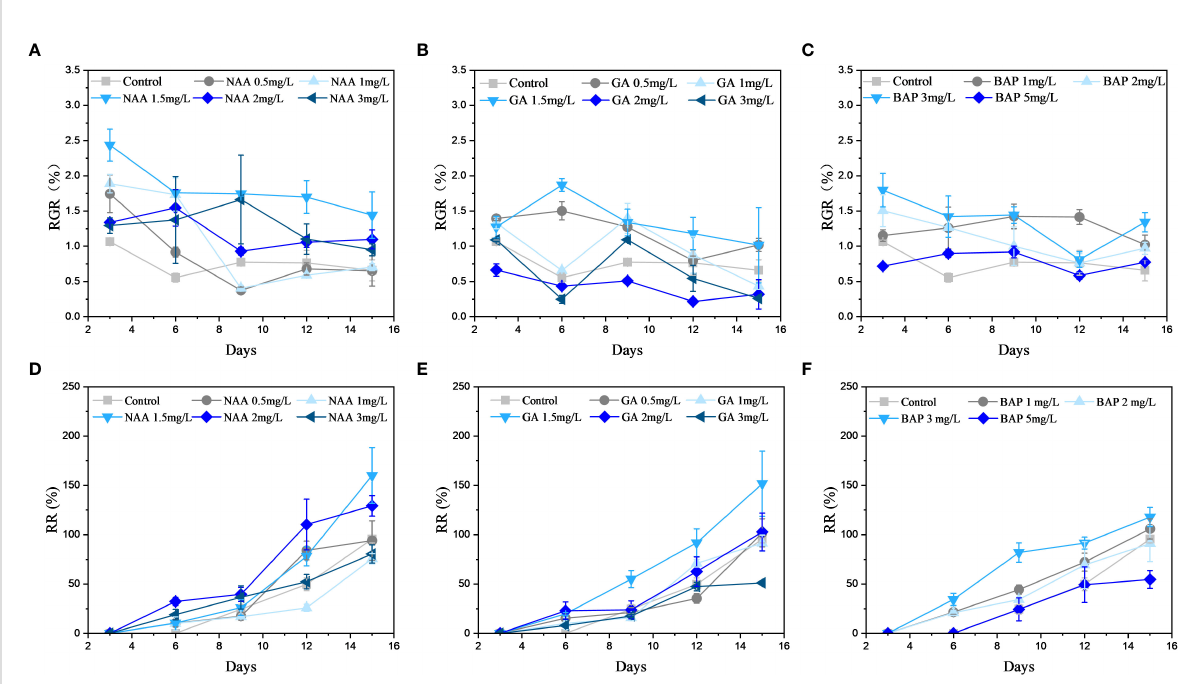
FIGURE 2 Effects of three exogenous hormones on the relative growth rate (RGR) and regeneration rate (RR) of Sargassum fusiforme holdfasts. (A – C) : relative growth rate; (D – F) : regeneration